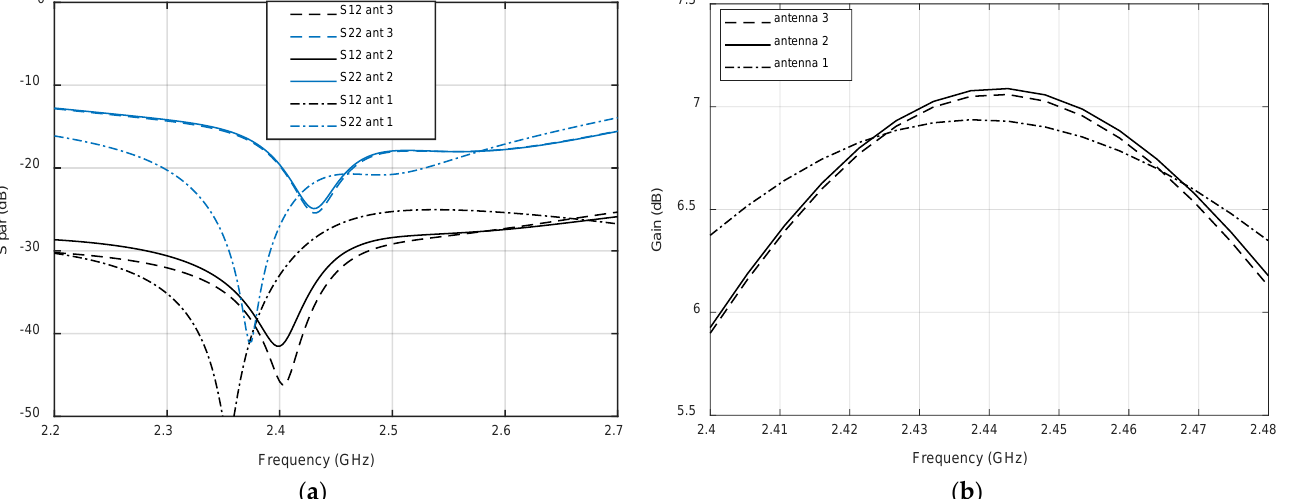
milling machine. All the substrates were mounted by hand in our